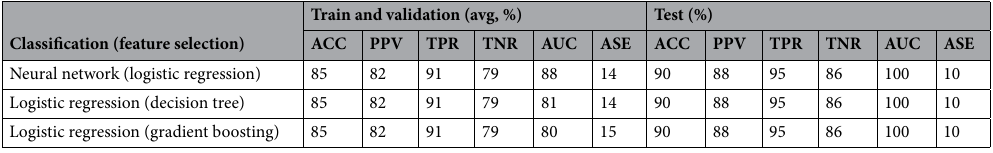
Table 11. Detailed metrics for three best performing classifiers on PDA data